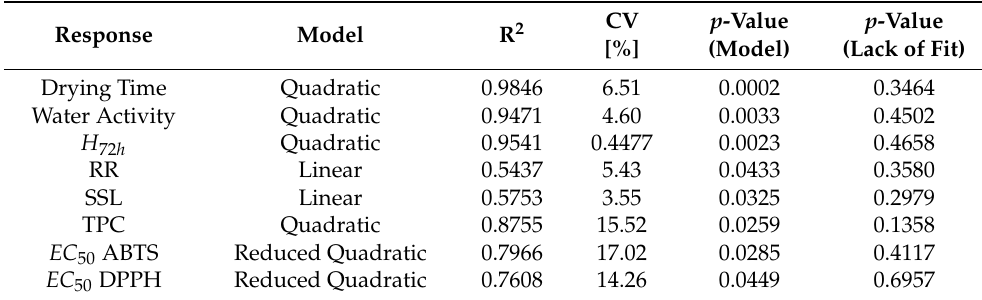
Figure 2. Response surface of drying time to MR = 0.02 of apples treated with PEF prior to micro- wave-convective drying, depending on the microwave power (factor A) and specific energy intake (factor B). Table 3. The results of statistical tests of fitting the equations of the response surfaces to the values obtained experimentally (α = 0.05); R 2 (determination coefficient), CV (coefficient of variation).